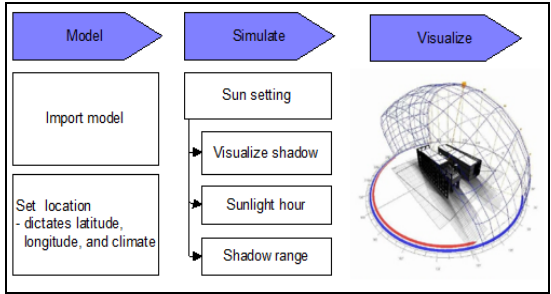
Figure 2. Shadow analysis method